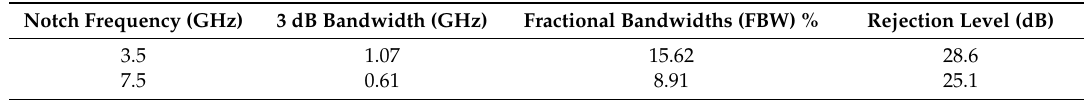
Table 3. Simulation results of the dual notched bands.